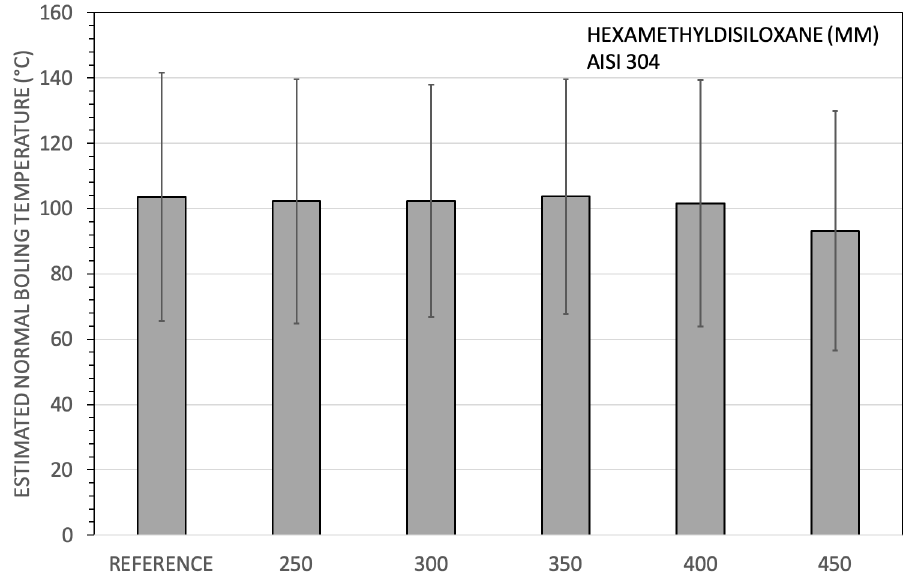
Figure 4. Normal boiling temperatures of a sample of hexamethyldisiloxane (MM) after it remained at different temperatures for one hundred hours each time.